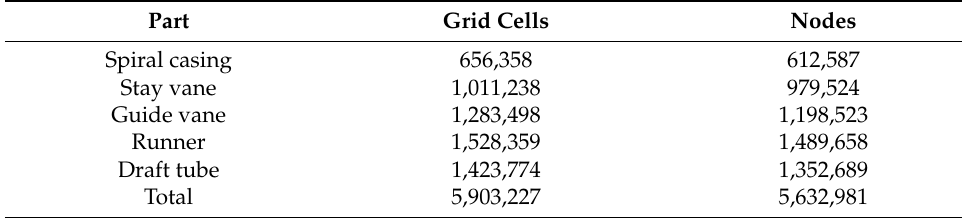
Table 2. Number of grids and nodes.